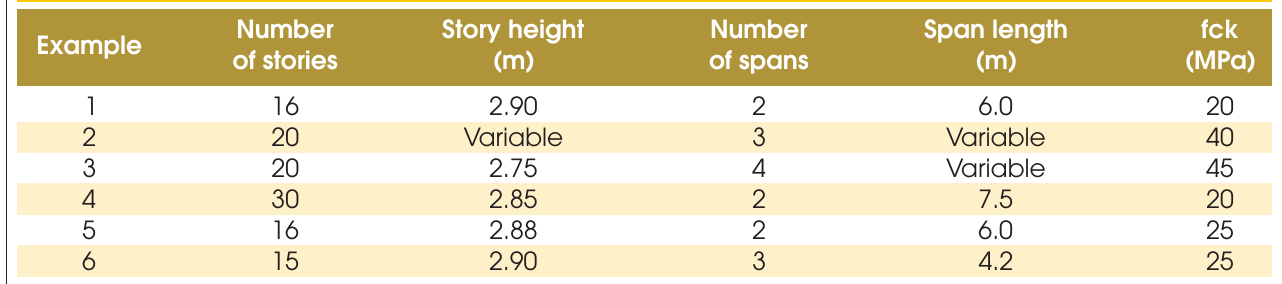
Table 1 – Main characteristics of the examples